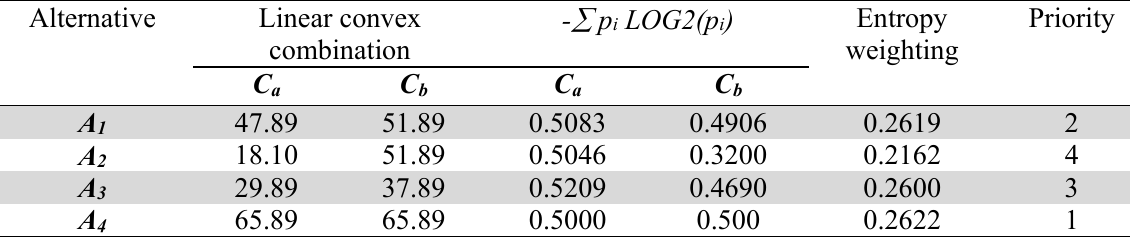
Moderate Entropy Weighting with  -level=0.15 Alternative